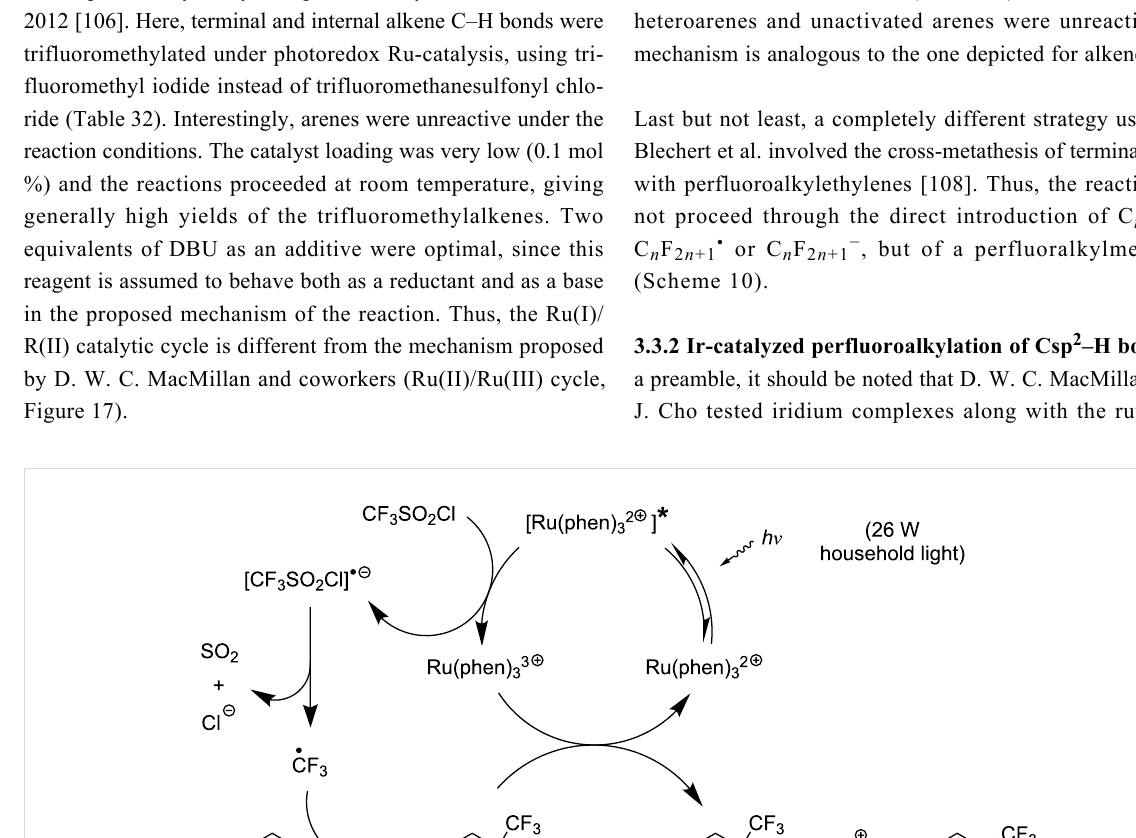
carried out and proved successful (Figure 16). The mechanism of the reaction was similar to that proposed by N. Kamigata et al. (Figure